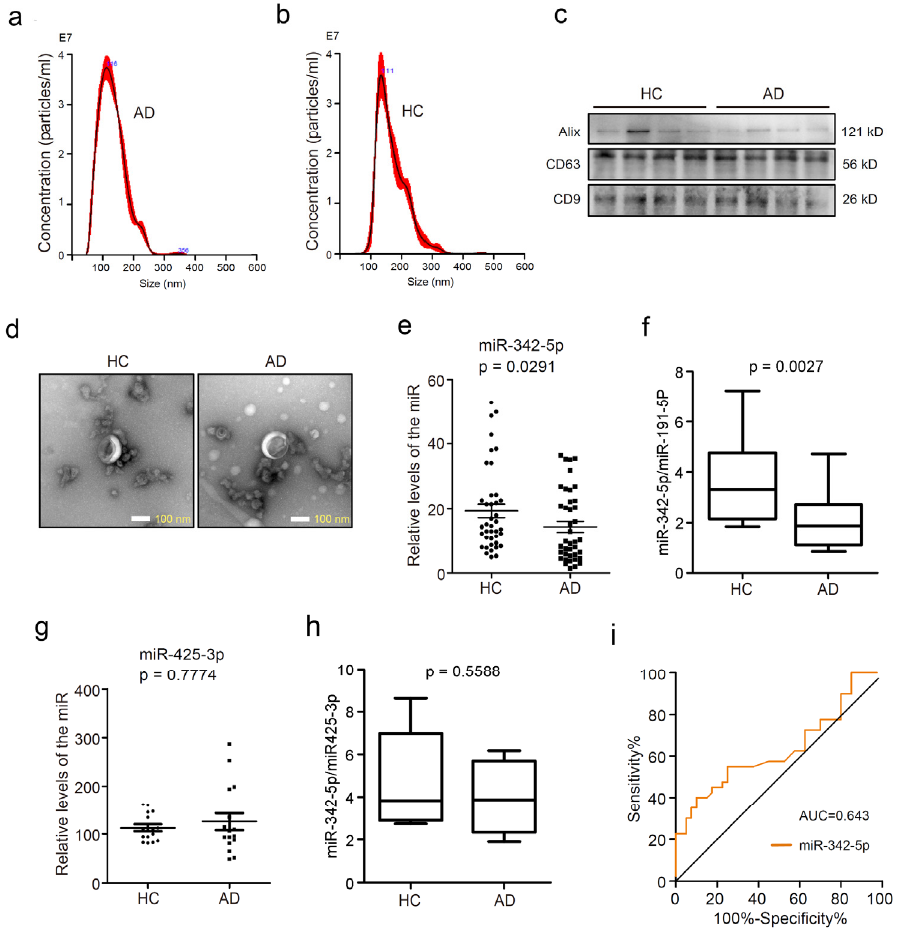
Figure 1. Circulating sEV miRNA-342-5p was downregulated in patients with Alzheimer’s disease (AD) compared with healthy controls (HC). ( a ) Nanoparticle Tracking Analysis (NTA) histograms of purified circulating sEVs from AD patients. The horizontal axis represents the particle diameters (nm), and the longitudinal axis depicts particle concentrations (particles/mL) at each diameter. ( b ) NTA histograms of purified circulating sEVs from healthy controls; ( c ) tetraspanins CD63 and CD9, and Alix, the exosomal biomarkers were detected using Western blot assay. ( d ) The transmission electron microscopy (TEM) images exhibited the morphology of sEVs from healthy controls (left) and AD patients (right). Scale bars represent 100 nm. ( e ) RT-PCR assay was performed to quantify the level of miR-342-5p in circulating sEVs from healthy controls or AD patients, p = 0.0291. ( f ) The ratios of miR-342-5p to miR-191-5p in sEVs from 16 AD patients and 16 healthy controls were calculated, p = 0.0027. ( g ) MiR-425-3p levels in sEVs were evaluated in the HC and AD groups, p = 0.7774. ( h ) The ratios of miR-342-5P to miR-425-3p were calculated, p = 0.5588. ( i ) The receiver operating characteristic (ROC) curve and area under the curve (AUC) were applied to estimate the diagnostic performance of sEVs miR-342-5p in distinguishing AD patients from normal